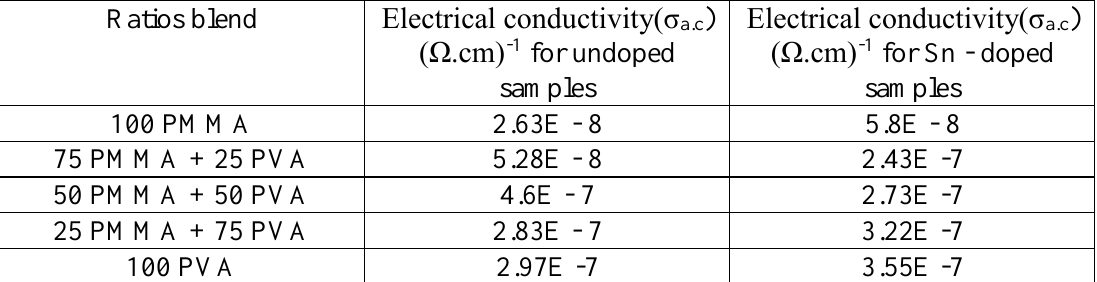
(b) Fig. 3: Variation of ln(σ) with ln (ω) for PMMA/PVA blends (b) Doped with 2% Sn . Table 1: Values of electrical conductivity at frequency 5 MHz for PMMA / PVA blends undoped and doped with 2% Sn .